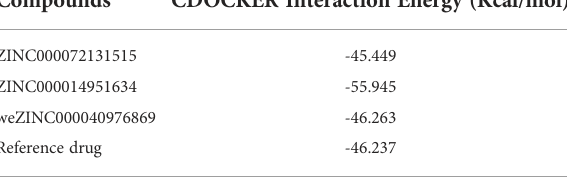
TABLE 4 CDOCKER interaction energy of the signi fi cant materials and the reference drug with MAPKAPK2. Compounds CDOCKER Interaction Energy